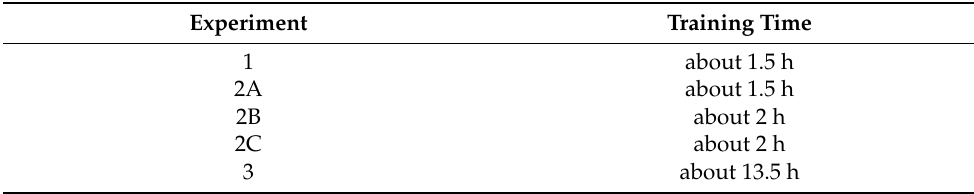
Table 2. Training time for each